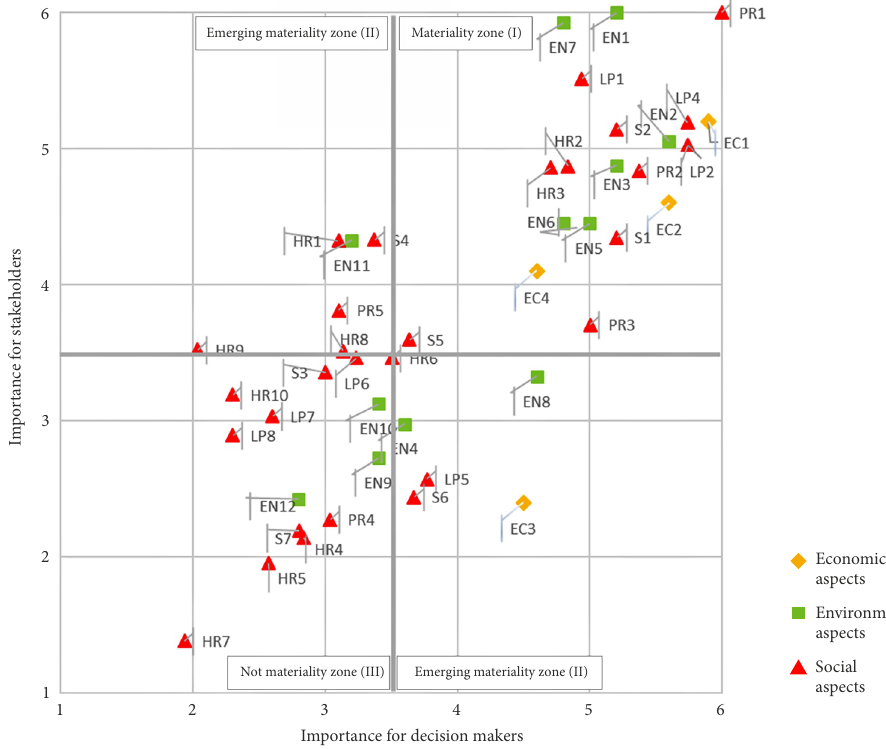
Figure 1. ACMO’s materiality matrix